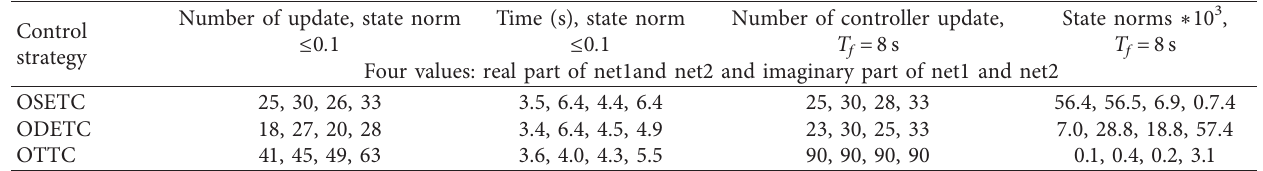
Table 1: Six control strategies for synchronization of CMRDNNs.